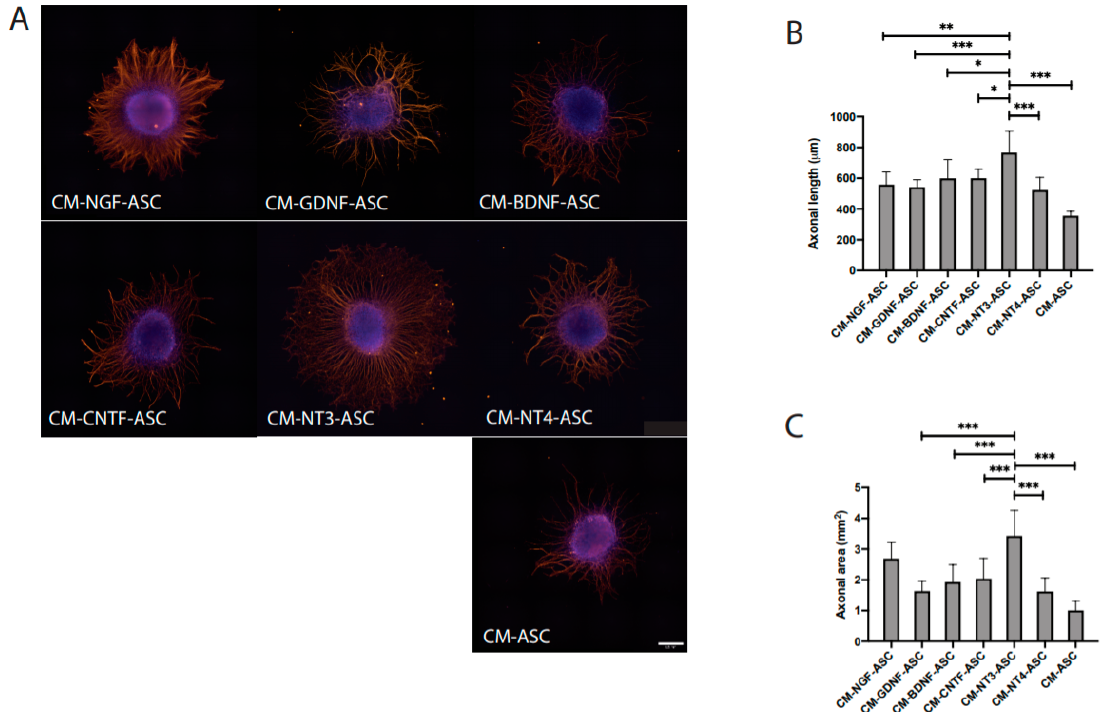
Figure 3. Neurotrophic potency of conditioned medium (CM) derived from NTF-stimulated ASC for supporting axonal regeneration. ( A ) Microphotographs of DRG explants treated with CM derived from NTF-stimulated ASC, ( B ) Quantitative measurements of axonal length ( µ m), and ( C ) Measurements of axonal area ( µ m 2 ). The scale bar represents 500 µ m. The bars represent mean ± SD of n = 12. Significant differences are indicated as * p < 0.05, ** p < 0.01, and *** p < 0.001.